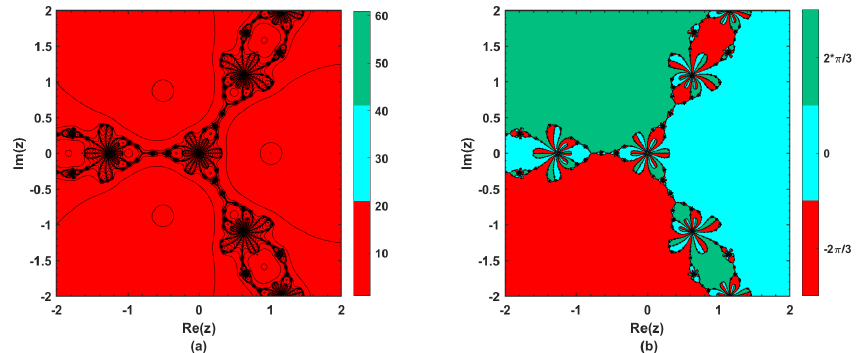
Figure 3. The polynomiographs obtained by the proposed method PS9 for P 3 ( z )